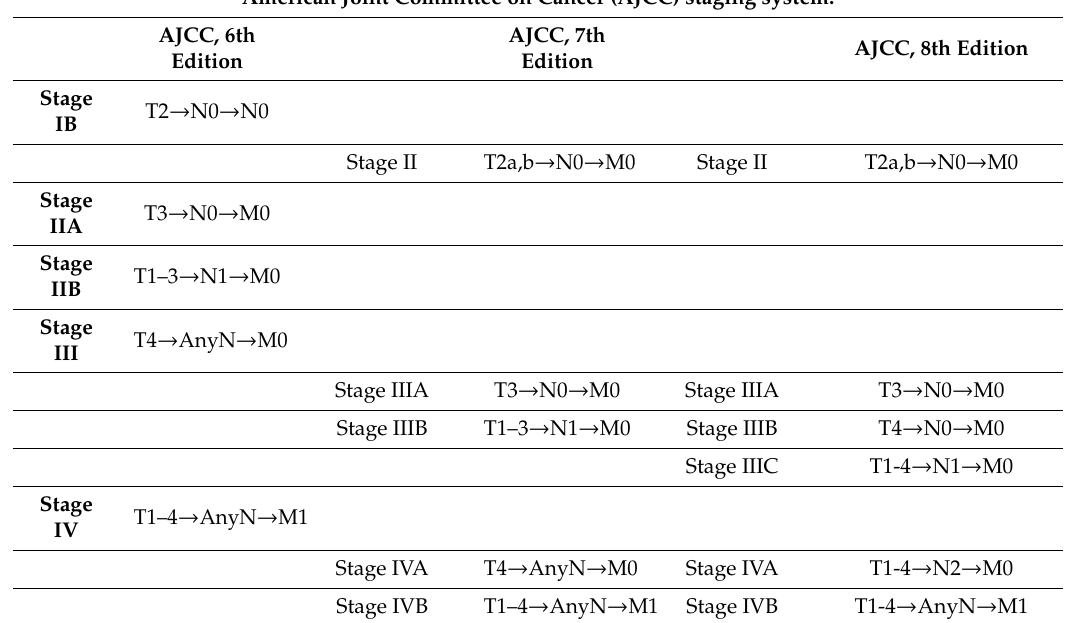
American Joint Committee on Cancer (AJCC) staging